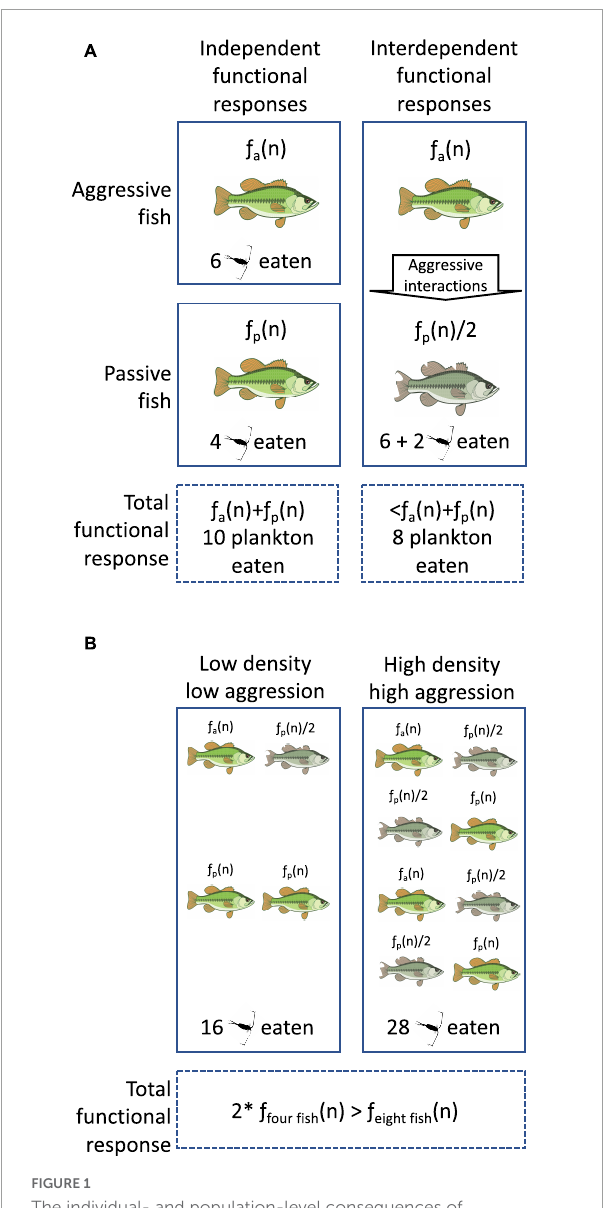
FIGURE1 The individual- and population-level consequences of interdependent functional responses. Fish eat plankton with the per capita functional response, f(n). Aggressive and passive fish have different functional responses before any aggression. (A) In the same pond as aggressive fish, the stress of aggression halves the functional responses of passive fish, decreasing how many plankton are eaten compared to the two fish separately. (B) At the population level, increased density increases the rate at which aggressive fish reduce the functional responses of passive fish. Thus, doubling the density of fish and holding constant the ratio of aggressive to passive fish does not double the number of plankton eaten. ∗ Means multiplied